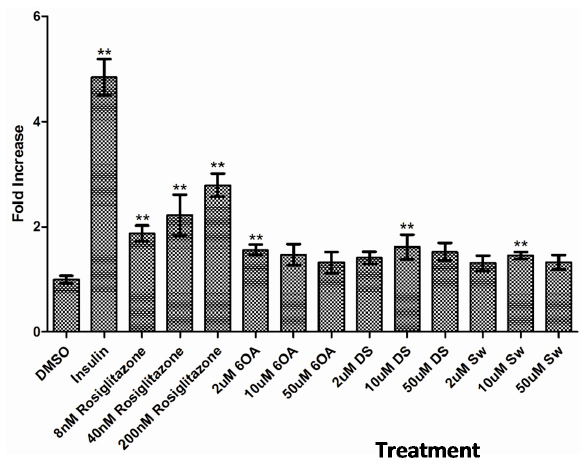
Figure 4. The semi-quantification of lipid droplets produced by differentiated 3T3-L1 cells at day 7 after the compound treatment. The quantification was performed by dissolving the cells in isopropanol and measuring the absorbance read out at 510 nm. The bar graph shows the relative fold increase of ORO in the cells treated with insulin, 6OA, DS and Sw compared with DMSO. The symbol ** denotes a significant difference at p < 0.01 compared with DMSO (Tukey’s test, n = 3). 2.4. mRNA Expression of PPAR γ and Selected Adipogenic Markers in Mature Differentiated 3T3-L1 Adipocytes